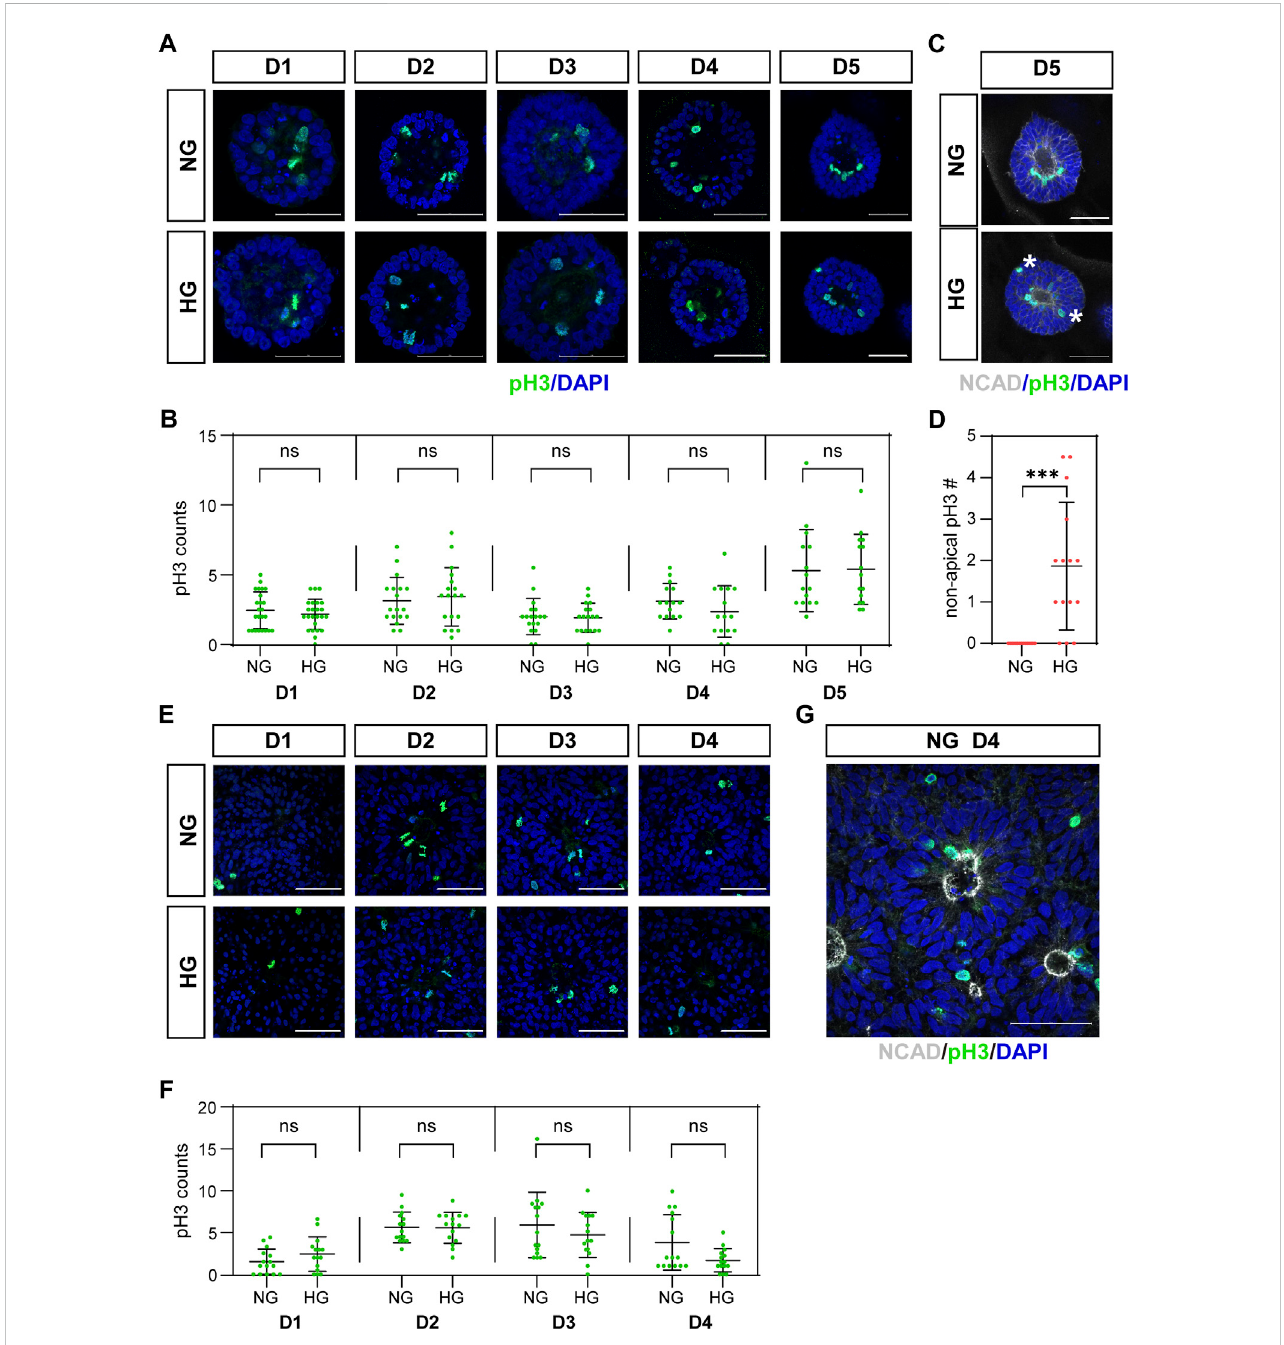
FIGURE 2 (C) Highglucosedisrupted apical location of pH3 positive cells inthe 3D model but not in therosette model.pH3 (green) staining was performed in both models. The representative images were shown in (A) for the 3D cyst model and (E) for the rosette model. The number of pH3-positive dividing cells was presented in (B,F) , respectively. N ≥ 15/condition. (C) Double immuno fl uorescence images of pH3 (green) and NCAD (grey) at D5 of the cysts. Asterisks mark dividing nuclei located at non-apical positions. The statistical analysis of apical and non-apical located pH3 positive cells at D5 of neuroepithelial cysts were presented in (D) N = 15/condition . (G) Double immuno fl uorescence images of pH3 (green) and NCAD (grey) at D4 after passage in the rosette model. NG, normal glucose. HG, 2X high glucose. DAPI (blue) shows the nucleus. All scale bar = 50 μ